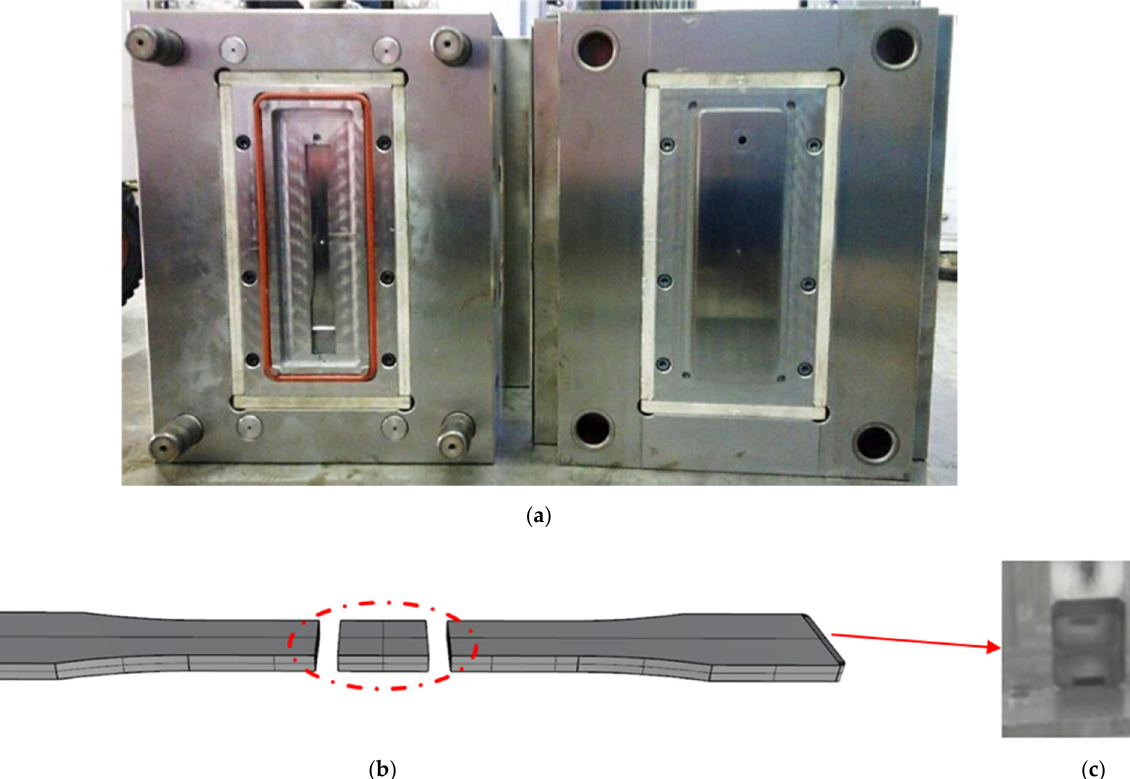
Figure 2. ( a ) Mold for the tensile test samples. ( b ) Specimen for fiber orientation and through-plane electrical conductivity (TPEC) analyses. The specimen is 143 mm × 19 mm × 3 mm, following the ASTM-D638 Type I standard. ( c ) Gas counter pressure (GCP) inlet position.